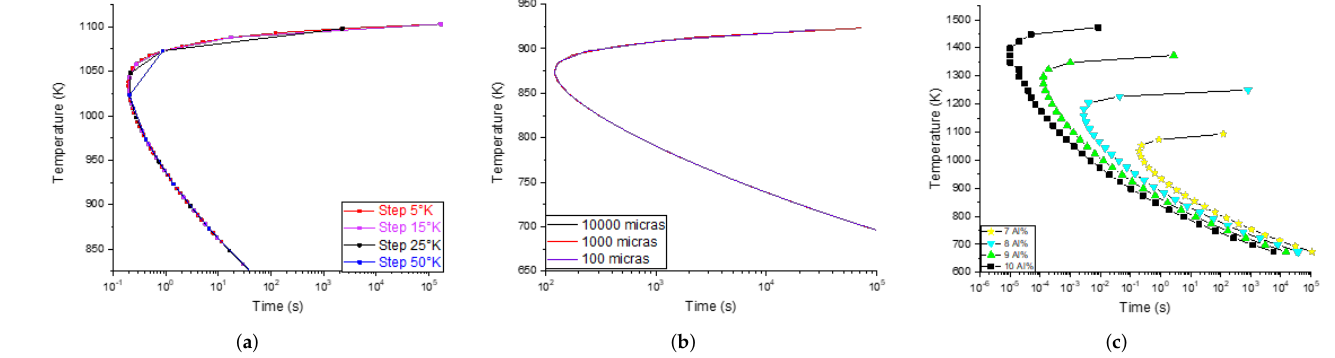
Figure 3. Comparison of simulated TTT diagrams varying ( a ) steps , ( b ) grain size and ( c ) chemical composition. It is observed that only the chemical composition has a considerable impact on the TTT diagrams. Due to this, the steps and grain size were discarded as inputs to the ANNs. With all sets of simulated TTT diagrams, two databases were created. Each DB is composed of the Euclidean coordinates of the points that describe the curve. The first, and following the proposed by [4], was used to predict only the nose point of the diagrams. The nose point is the shortest time that a phase requires for its precipitation. The second DB was used to predict the complete TTT curves. In this case, the curves of each diagram are divided from the nose point, into an upper and lower part (sub-curves). In addition, since the TTT curves are not symmetrical, values for the shorter sub-curve were interpolated to obtain the same number of coordinates for both segments. Each DB was divided into two, the nose point DB consists of 96 data points, and the complete curve DB consists of 19,296 data points. The first part was used to train the models (66% of data) the second part was used to validate the models (33% of